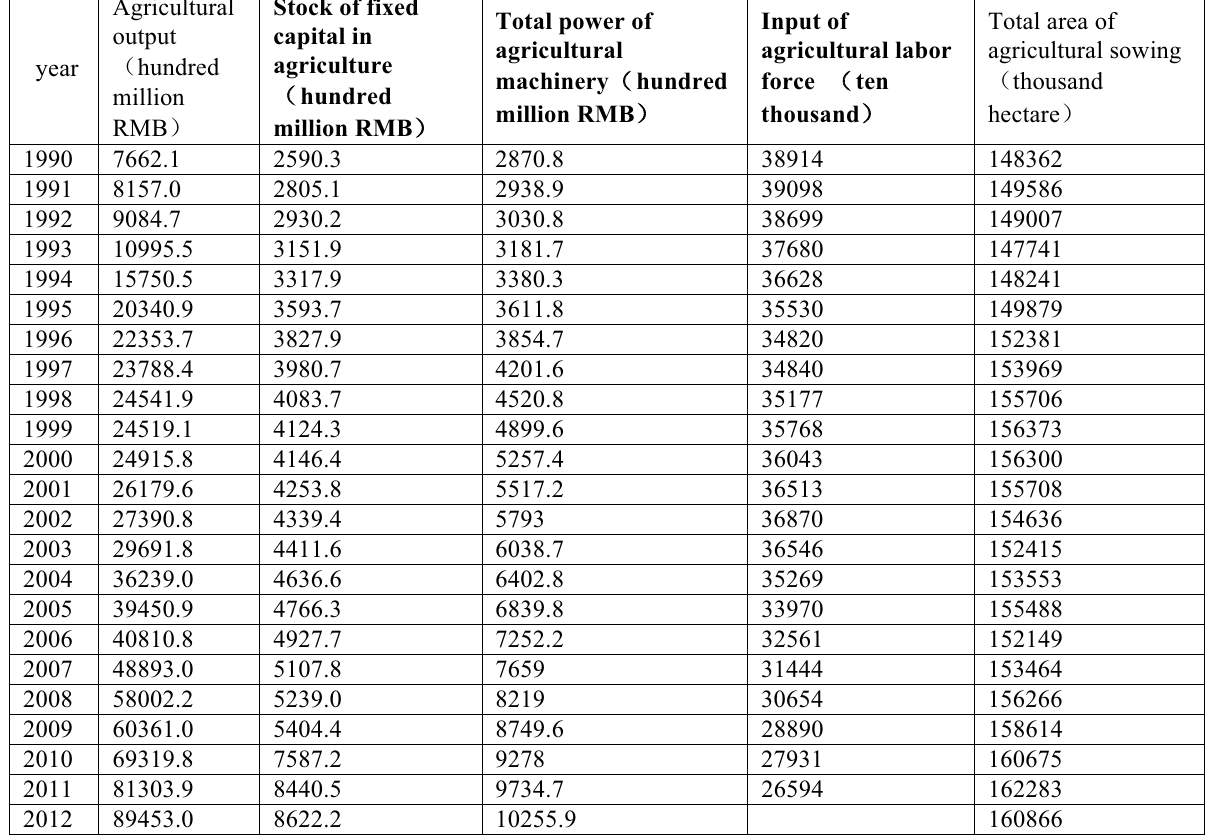
Table 1. Elements of agricultural inputsand output of agricultural inputs from 1990 to 2012